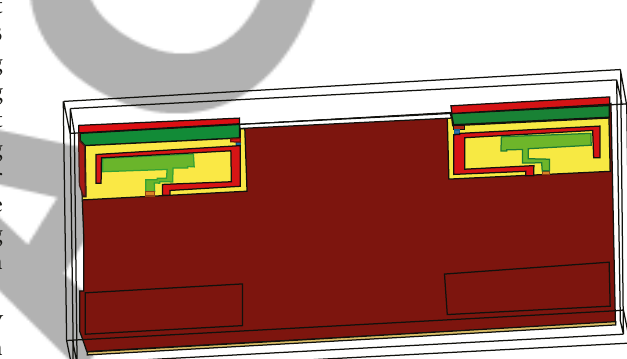
Figure 6: Value of 𝑆 11 under the different environment.